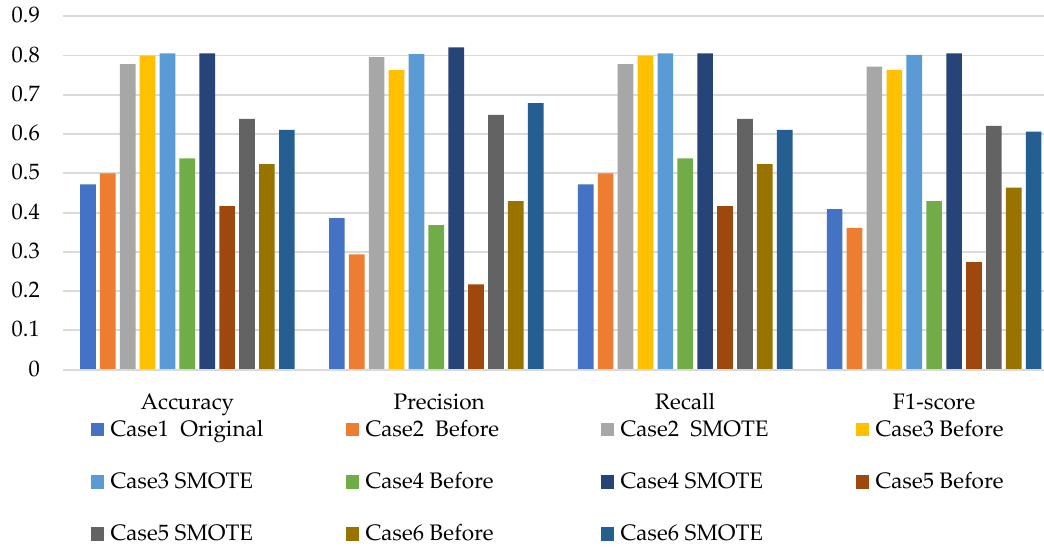
Figure 12. Simulation performance of k-NN classification with T-link.